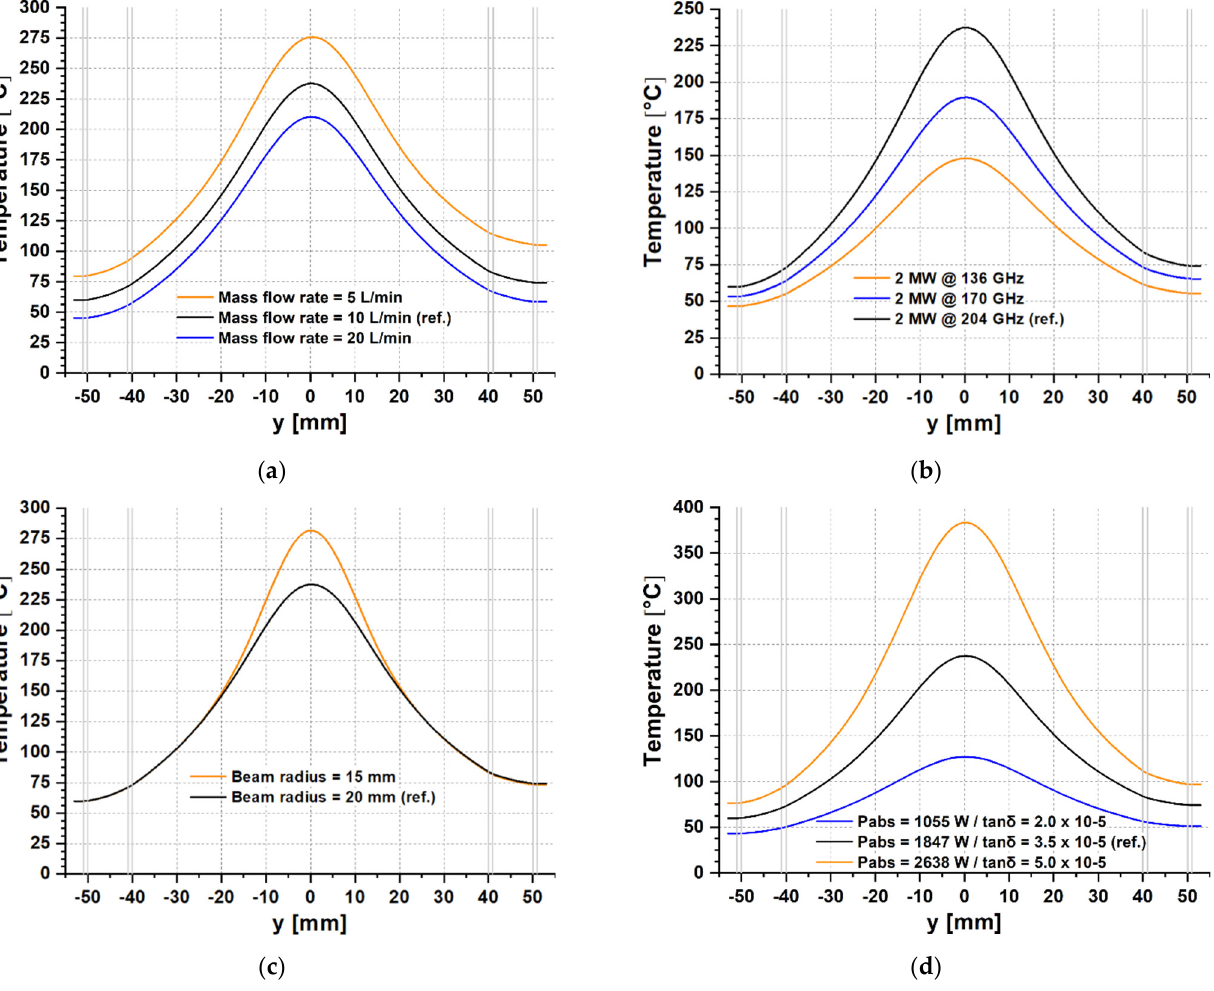
Figure 5. Temperature profiles along the disk diameter at the symmetry plane xy for different values of the ( a ) inlet mass flow rate; ( b ) beam frequency; ( c ) beam radius; ( d ) loss tangent. Table 1. Pressure and temperature results obtained from the sensitivity analysis regarding the inlet mass flow rate.